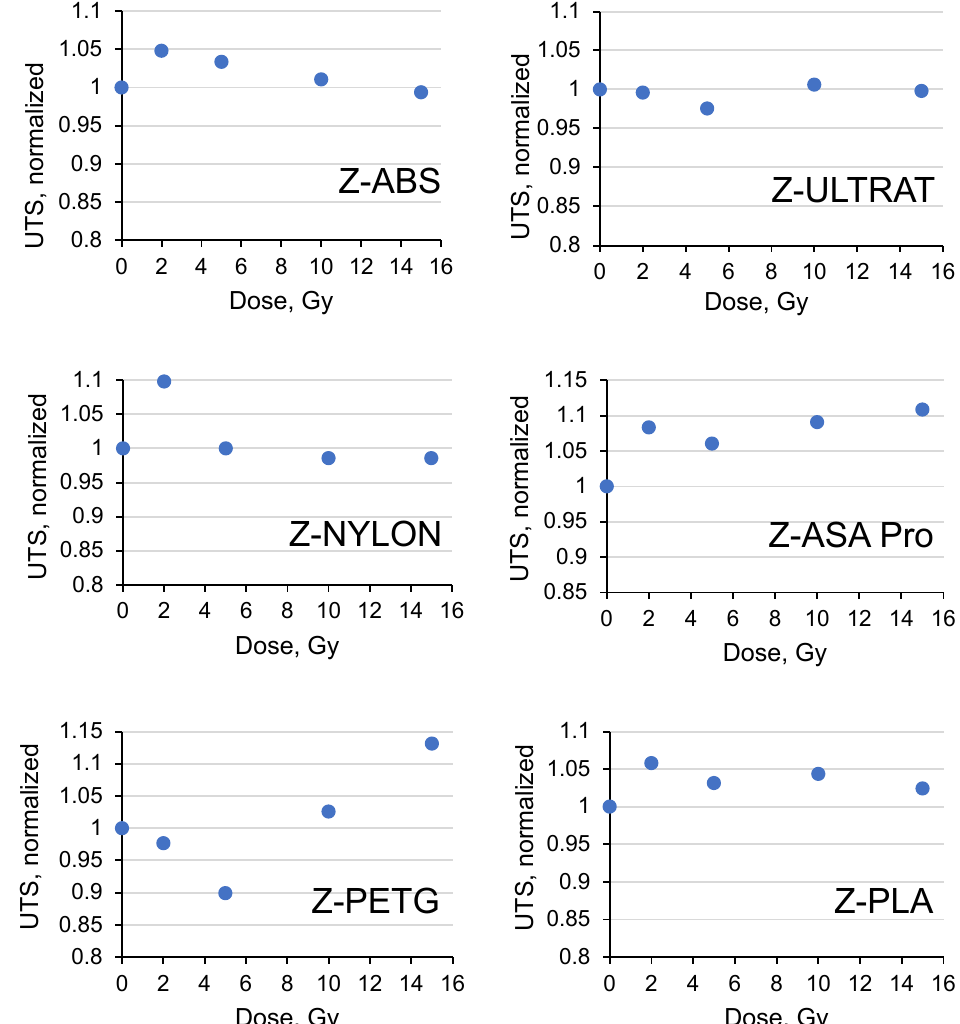
Figure 5. Variations in ultimate tensile strain (UTS) of the irradiated 3D printed fi laments.